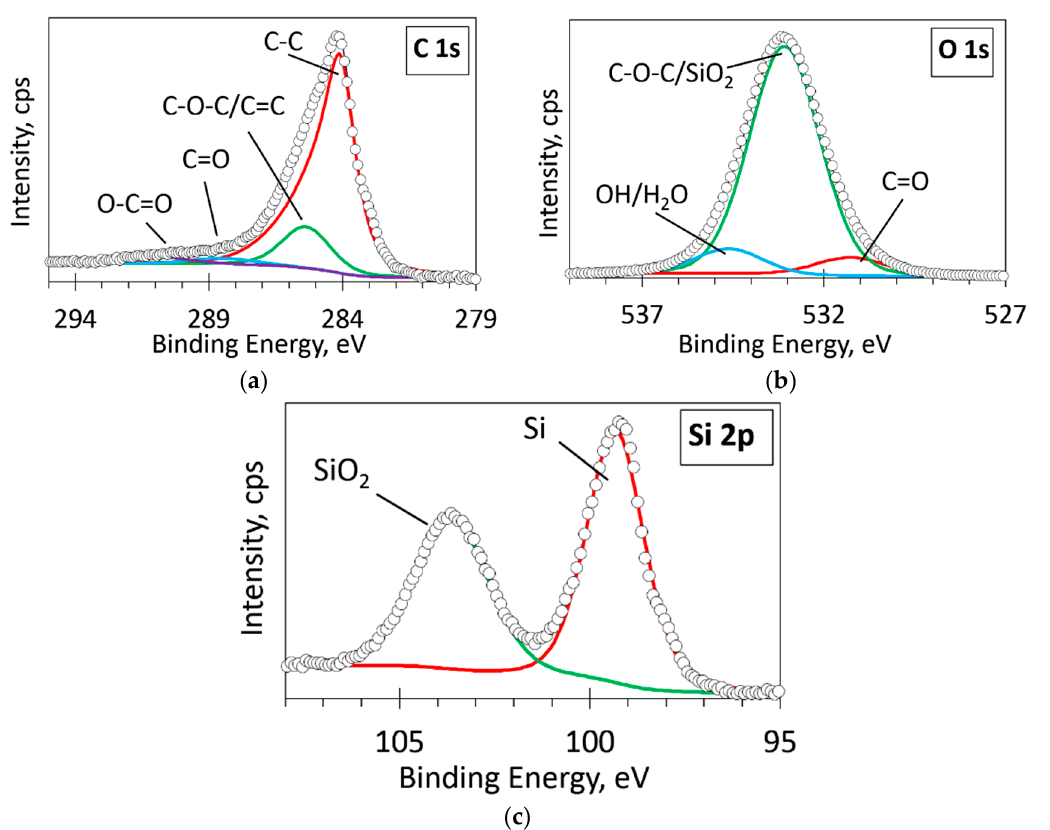
Figure 12. The deconvoluted high ‐ resolution XPS spectra of the sample for carbon ( a ), oxygen ( b ), silicon ( c ). Circles—acquired spectra, thin black line—an envelope of fitted spectra, color thick lines—fitted peaks.